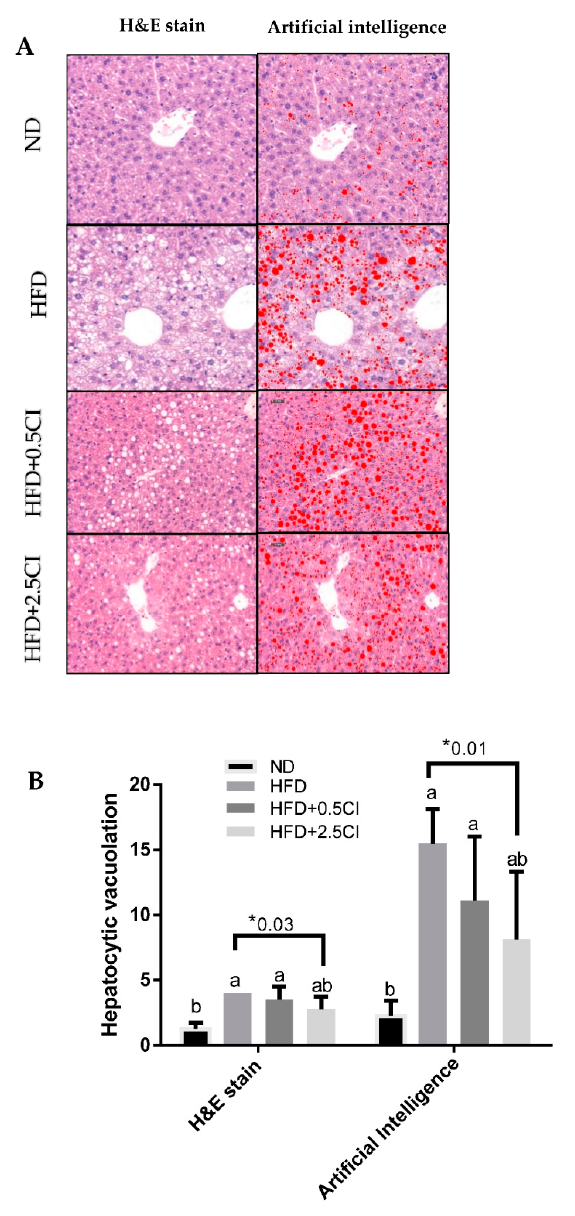
Figure 4. Effects of Chiliadenus iphionoides supplementation on histology section of the perilob- ular region of the liver. Male C57BL/6J mice were fed with normal diet (ND), high-fat diet (HFD), high-fat diet + 0.5 mg/kg Chiliadenus iphionoides (HFD + 0.5CI), high-fat diet + 2.5 mg/kg Chiliadenus iphionoides (HFD + 2.5CI) for fifteen weeks. ( A ) Histological evaluation of the liver using H&E stain versus artificial intelligence; ( B ) Hepatocytic vacuolation evaluated by semi-quantitive grade presented as H&E stain or by % of fatty vacuoles in hepatocytes presented by artificial intelli- gence. Values are expressed as mean ± SEM ( n = 4). Different letters denote significant difference ( p < 0.05, Tukey’s HSD) asterisk denotes significant difference ( p < 0.05, Student’s t